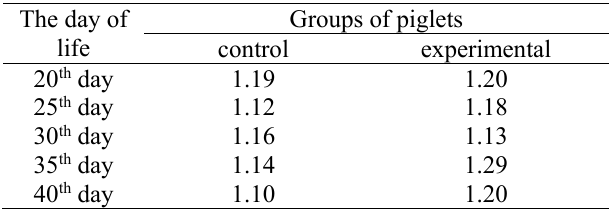
The activity of alanine aminotransferase in serum of piglets under the action of feed additive “Butaselmevit-plus”, mkat/l (M ± m, n = 5) Groups of piglets The day of life control experimental